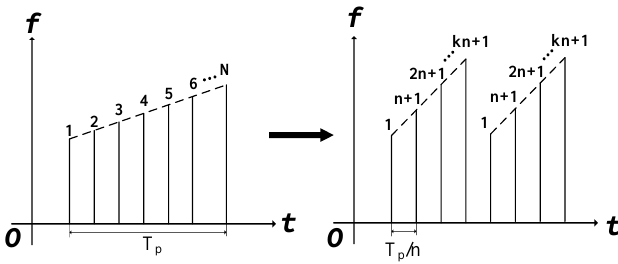
Figure 2. The principle of SMSP jamming.